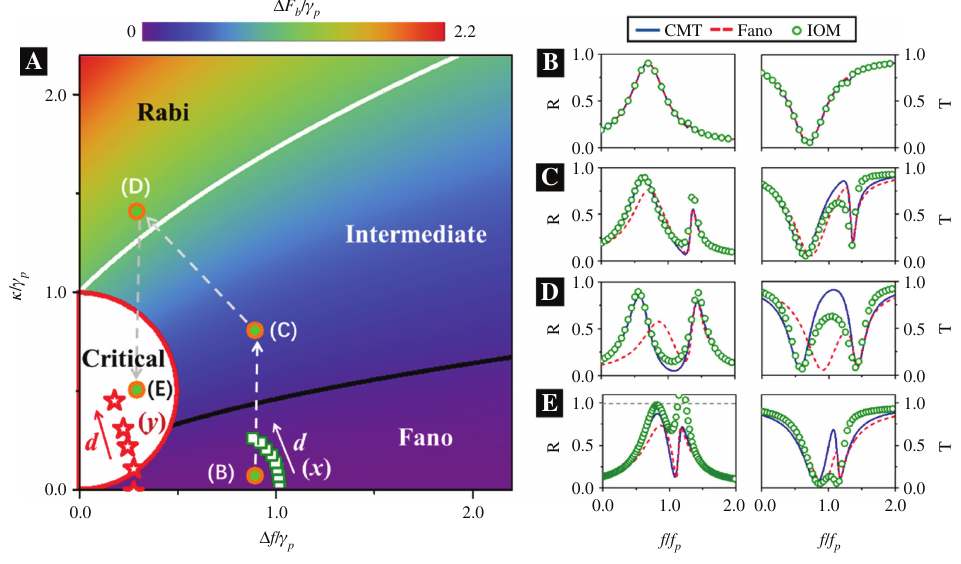
Figure 7: A generic phase diagram for the dark-bright coupled plasmonic systems. (A) Normalized frequency shift of the bright mode Δ F / γ (color map) versus Δ f / γ and κ / γ . The whole space is devided into 4 parts by b p p p = 1), the black line ( Δ F = 0.1) and the red line ( K = 0.25). Green squares and red stars denote the positions of the white line ( Δ F / γ / γ b p b p our samples for the cases of x - and y -polarizations. (B–E) Transmittance and reflectance spectra of four typical cases represented by the orange/green circles located at four different phase regions, calculated by the CMT, Fano’s formula, and the IOM,